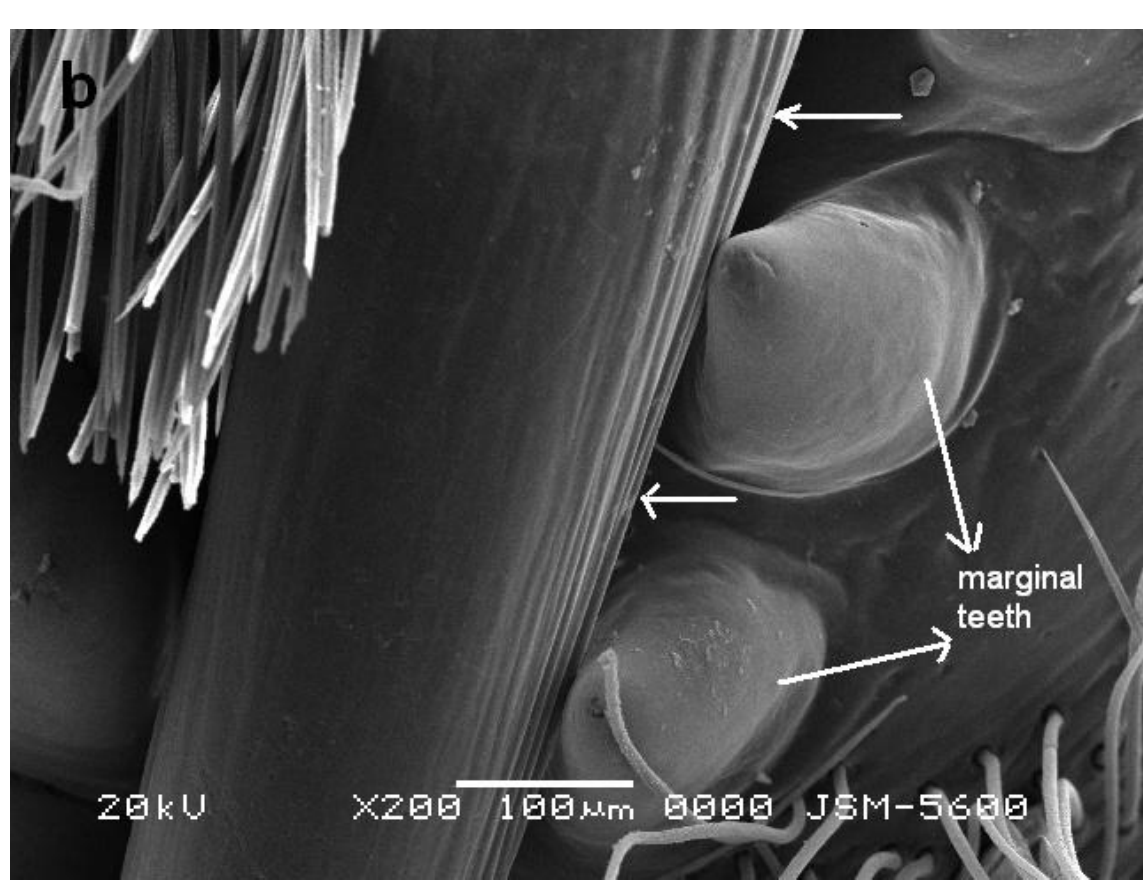
Figure 4. The fang, venom pore and marginal teeth ( a ); blade-like structures (arrows) in higher magnification ( b